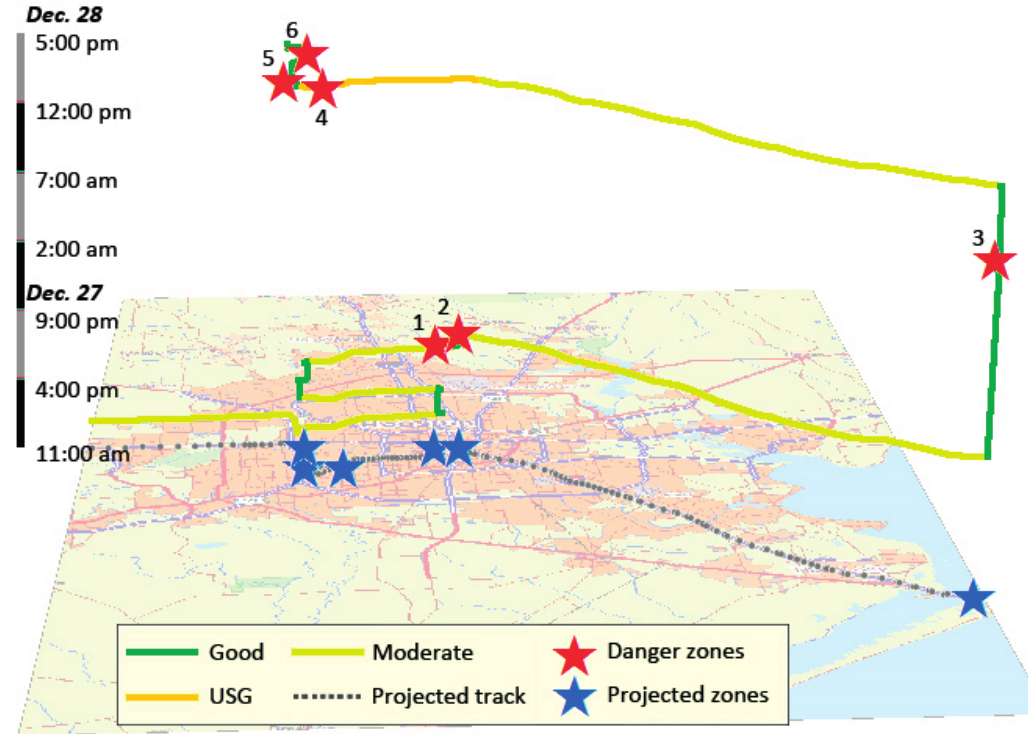
Figure 6. The personal air pollution danger zones for the volunteer in Houston, Texas on 27 and 28 December